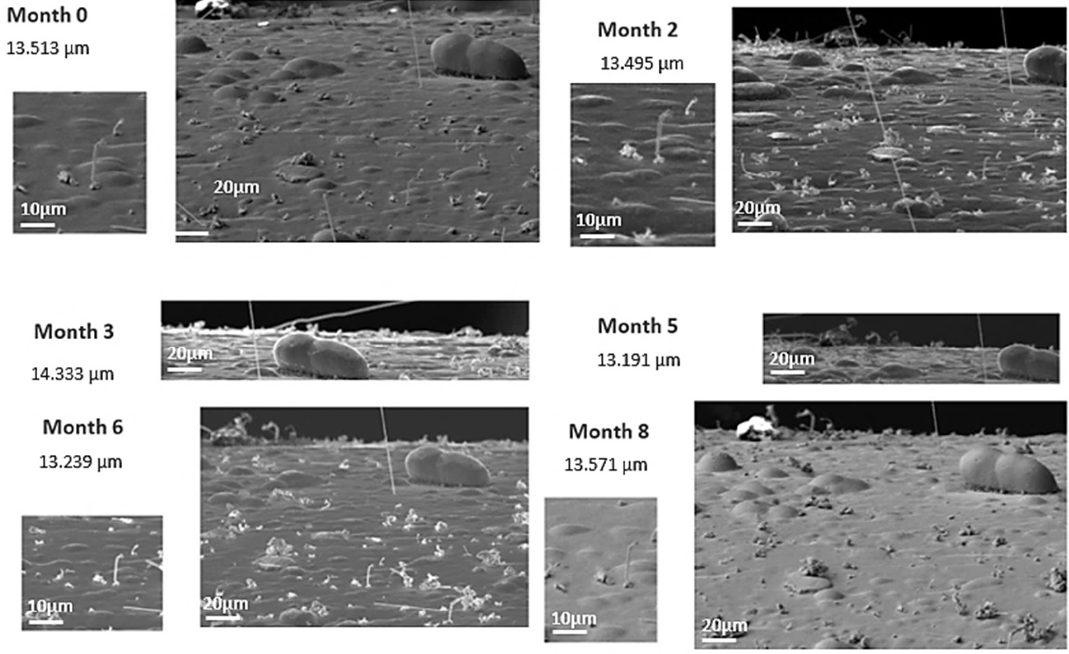
Figure 6. Example of evolution of a whisker in a white alkaline electrolyte sample without compressive stresses over time.